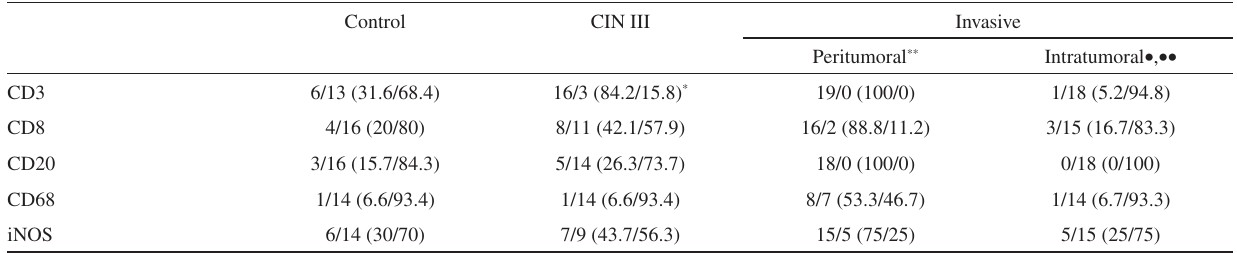
Table 1 - Distribution of CD3, CD8, CD20, CD68 and iNOS in the cervical stroma of control women, patients with CIN III and patients with invasive cervical cancer [n (%)] Control CIN III Invasive Peritumoral ** Intratumoral · , ··